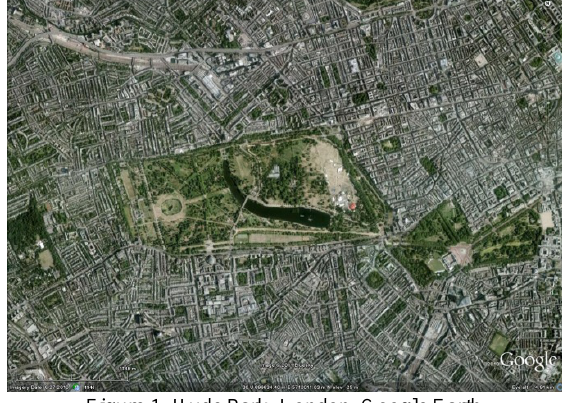
Figure 1. Hyde Park, London, Google Earth .